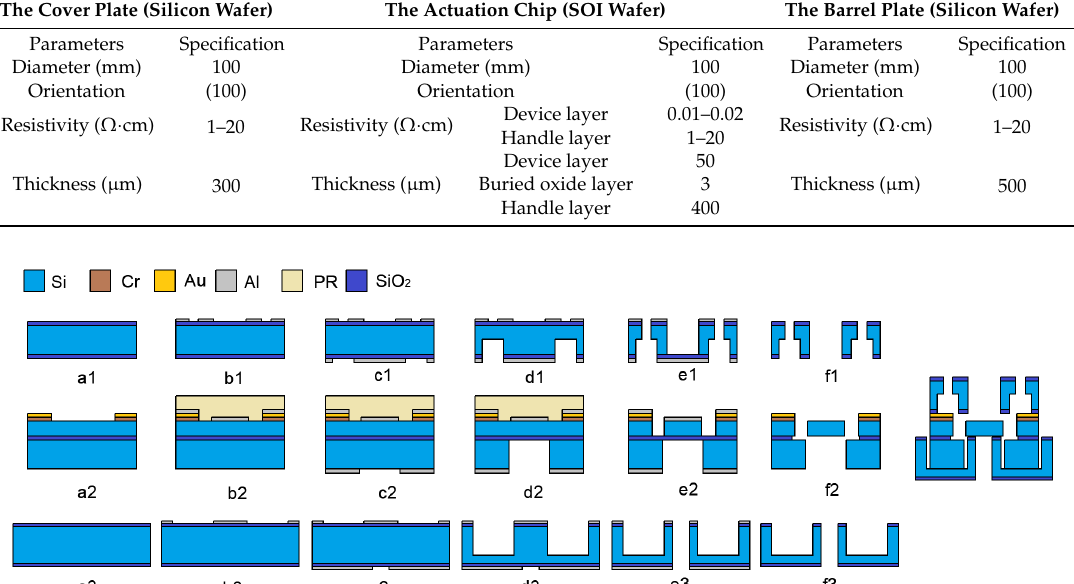
Table 2. Parameters of silicon wafer and silicon‑on‑insulator (SOI).